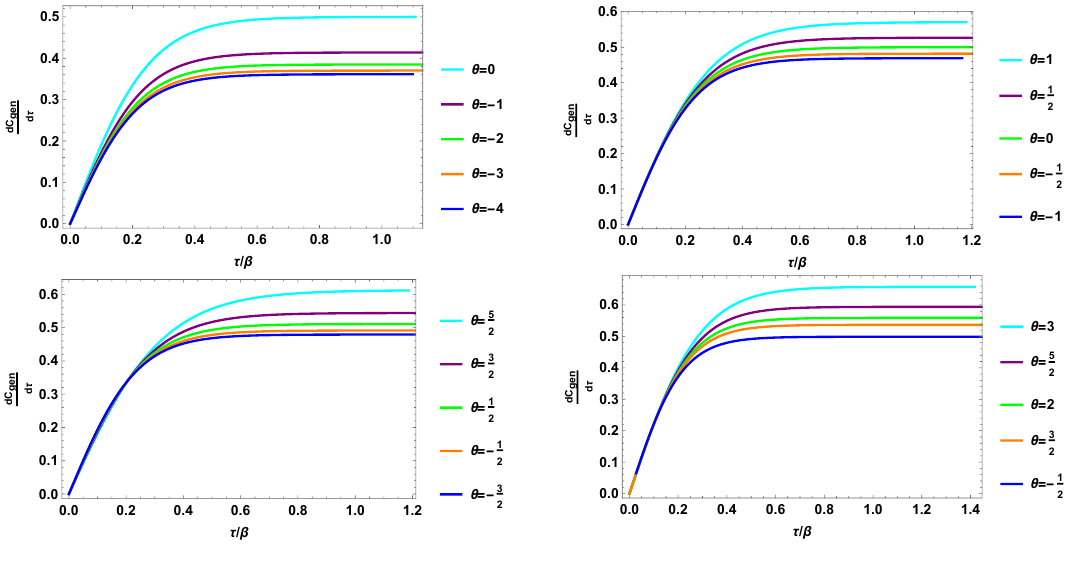
as a function of τ/β for λ 6 = 0 and different values of d , θ and z : Figure 13 . The growth rate d C gen dτ Top Left ) d = 1 , z = 1 , Top Right ) d = 2 , z = 2 , Down Left ) d = 3 and z = 3 , Down Right ) d = 4 and z = 3 . We set L = r = r = G = V = 1 and λ = 10 − 5 h F N d 2